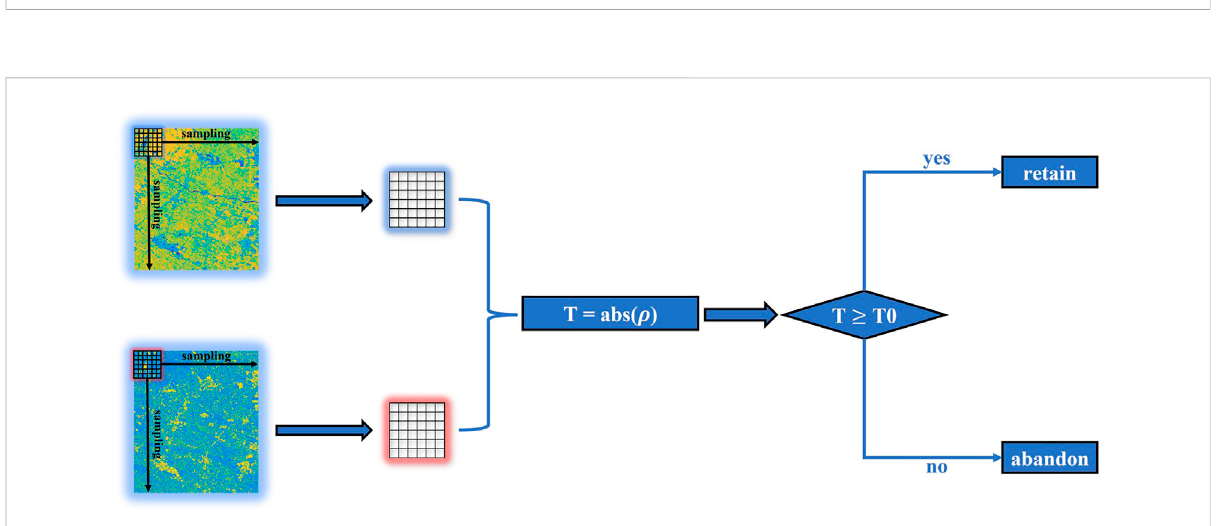
FIGURE 6 Window sampling method with improved correlation